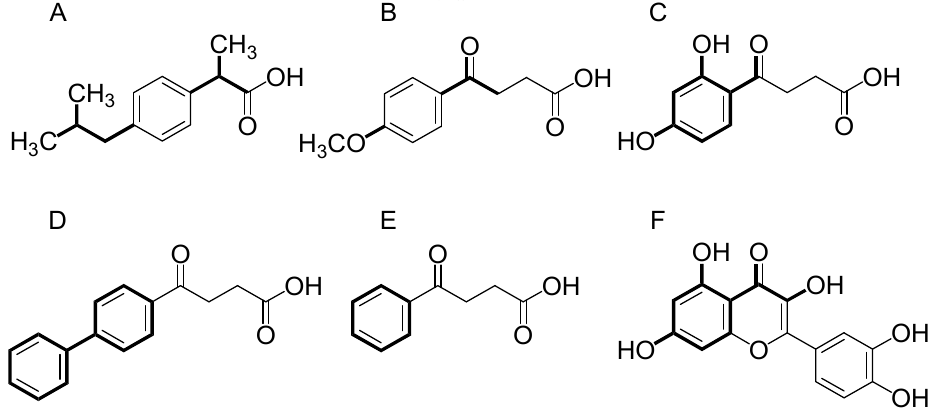
Figure 7. Aryl propionic and aryl butyric acid derivatives and modifications strategies. ( A ) Ibuprofen. ( B ) MBPA. ( C ) DHBPA. ( D ) Fenbufen ( E ) Fenbufen derivate. ( F ) Chemical skeleton of a flavonoid. Bold line - key groups of molecular modification strategies